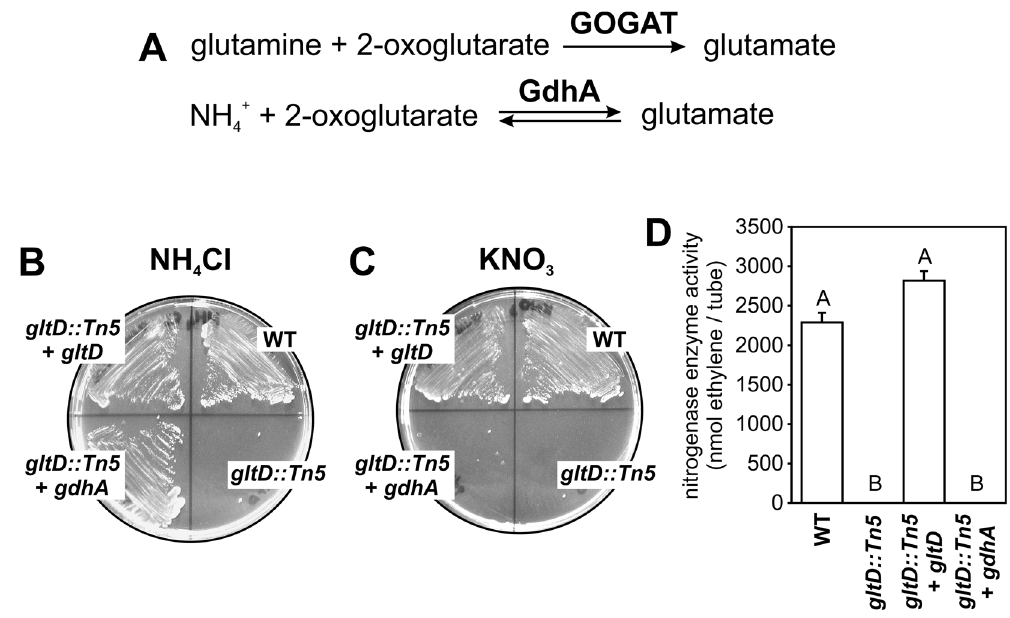
Figure 1. Growth and nitrogenase enzyme activity in free-living conditions of the Bradyrhizobium ORS285 gltD::Tn5 mutant. ( A ) Biosynthesis of glutamate catalysed by the glutamate synthase (GOGAT) and glutamate dehydrogenase (GdhA) enzyme. Growth of Bradyrhizobium ORS285 and derivatives on Minimal medium agar plates containing ( B ) 10 mM NH 4 Cl and ( C ) 10 mM KNO 3 as nitrogen source. ( D ) ORS285 gltD::Tn5 mutant has no nitrogenase enzyme activity under free-living conditions. Ethylene production of ORS285 and derivatives grown for 5 days in vacuette tubes containing BNM-B agar (0.8% w/v) medium without nitrogen source and 10% acetylene gas. The mean amount of produced ethylene per tube (n = 4) is indicated. Error bars represent standard errors of the mean and letters represent conditions with significant difference according to the Tukey’s test (P <